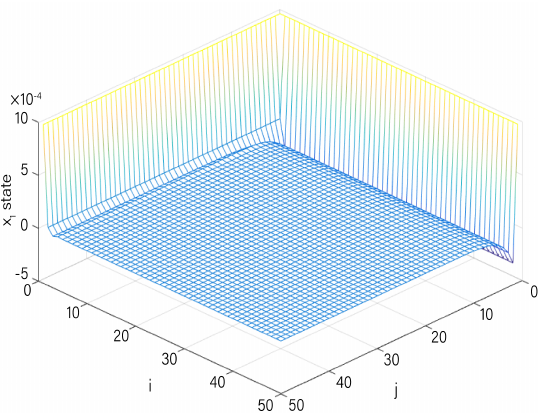
Figure 6. Closed-loop state space response of x 1 ( i , j ) when K = [0 0.05].